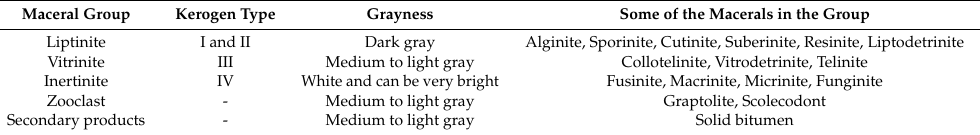
Table 1. Maceral groups classification of The Society for Organic Petrology / International Commission for Coal and Organic Petrology (TSOP / ICCP). (Modified from: [25,26,28]). Zooclast and Secondary products are not categorized in any kerogen